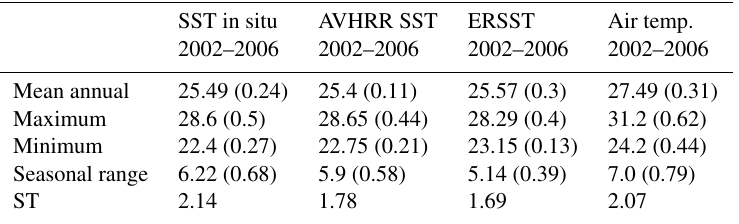
Table A1. Statistics of various sea surface temperature (SST) products and air temperature for Rodrigues with 1 σ standard deviations in brackets for the period 2002 to 2006 (period with in situ SST data). ST = 1 σ standard deviation over all years. All units in ◦